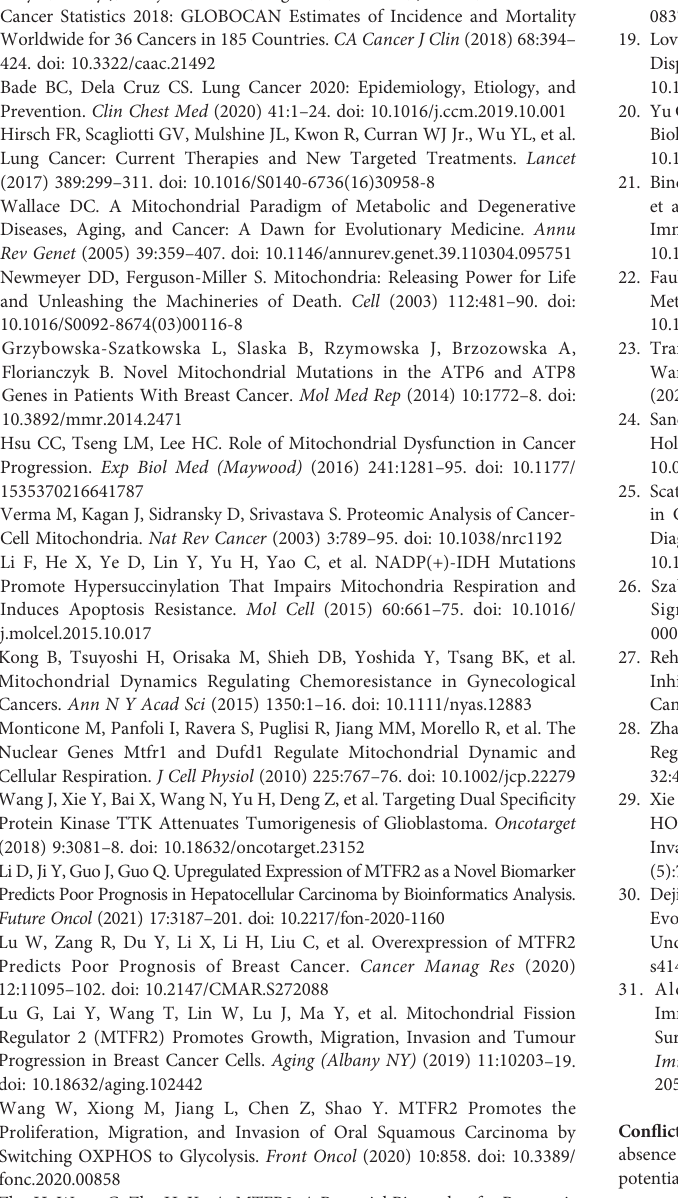
Supplementary Figure 1 | The forest plot indicated that MTFR2 was an indepent worse prognosis factor via unltivariate (A) , multivariate (B) and nomogram analyses (C) .